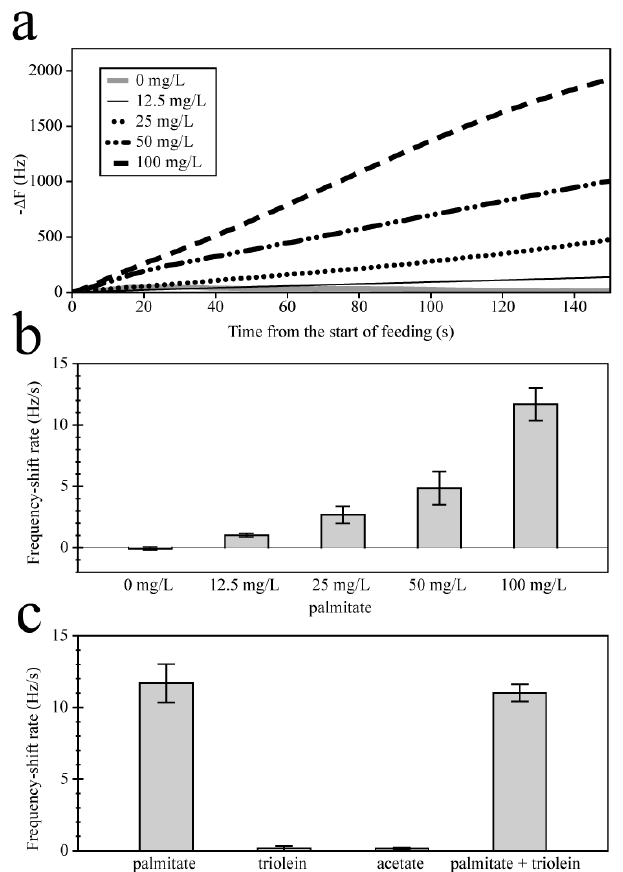
Figure 3. ( a ) Typical frequency change patterns during QCM measurements using different concentrations of palmitate; ( b ) absolute values of average frequency-shift rates ( n = 3) within the linear ranges (50–150 s) at each palmitate concentration; and ( c ) absolute values of average frequency-shift rates ( n = 3) within the linear ranges (50–150 s) obtained from solutions of different model compounds.